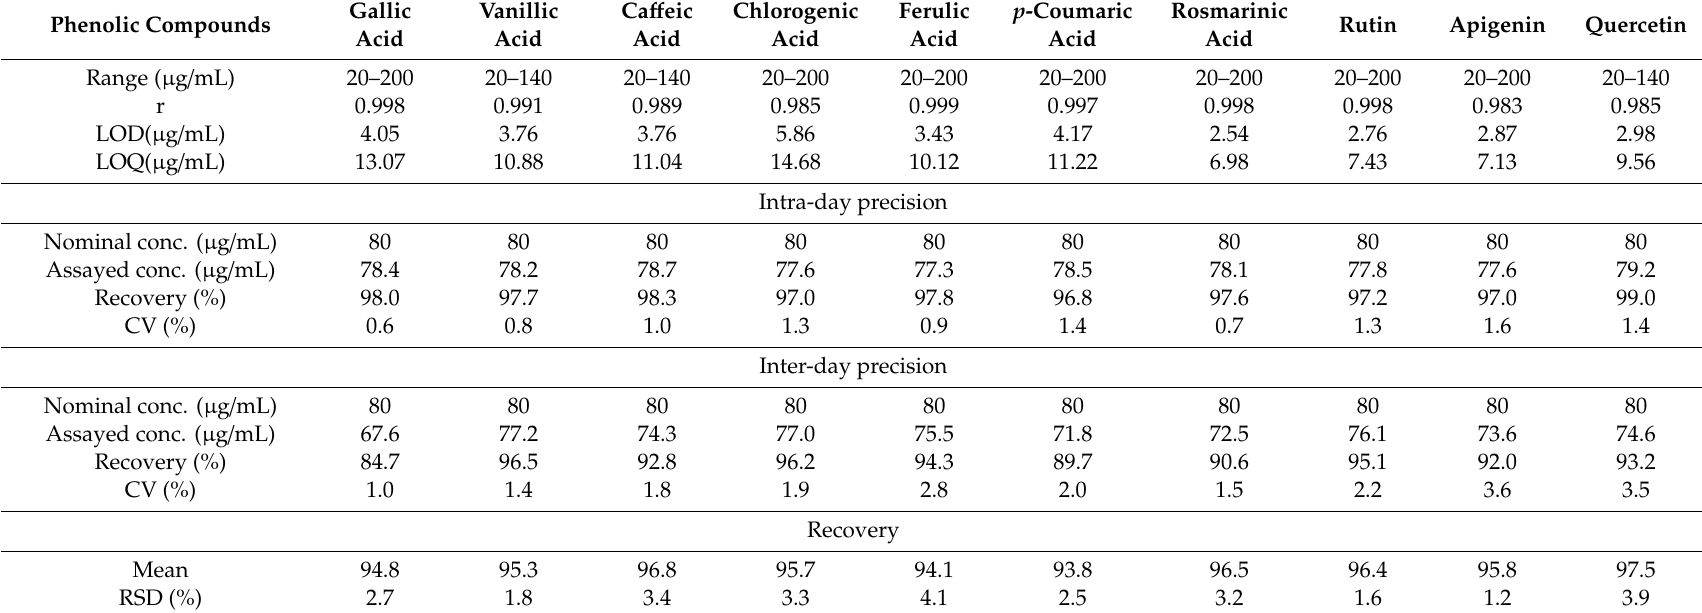
Table 1. Validation parameters for the phenolic compounds in Morus alba L. ( n =